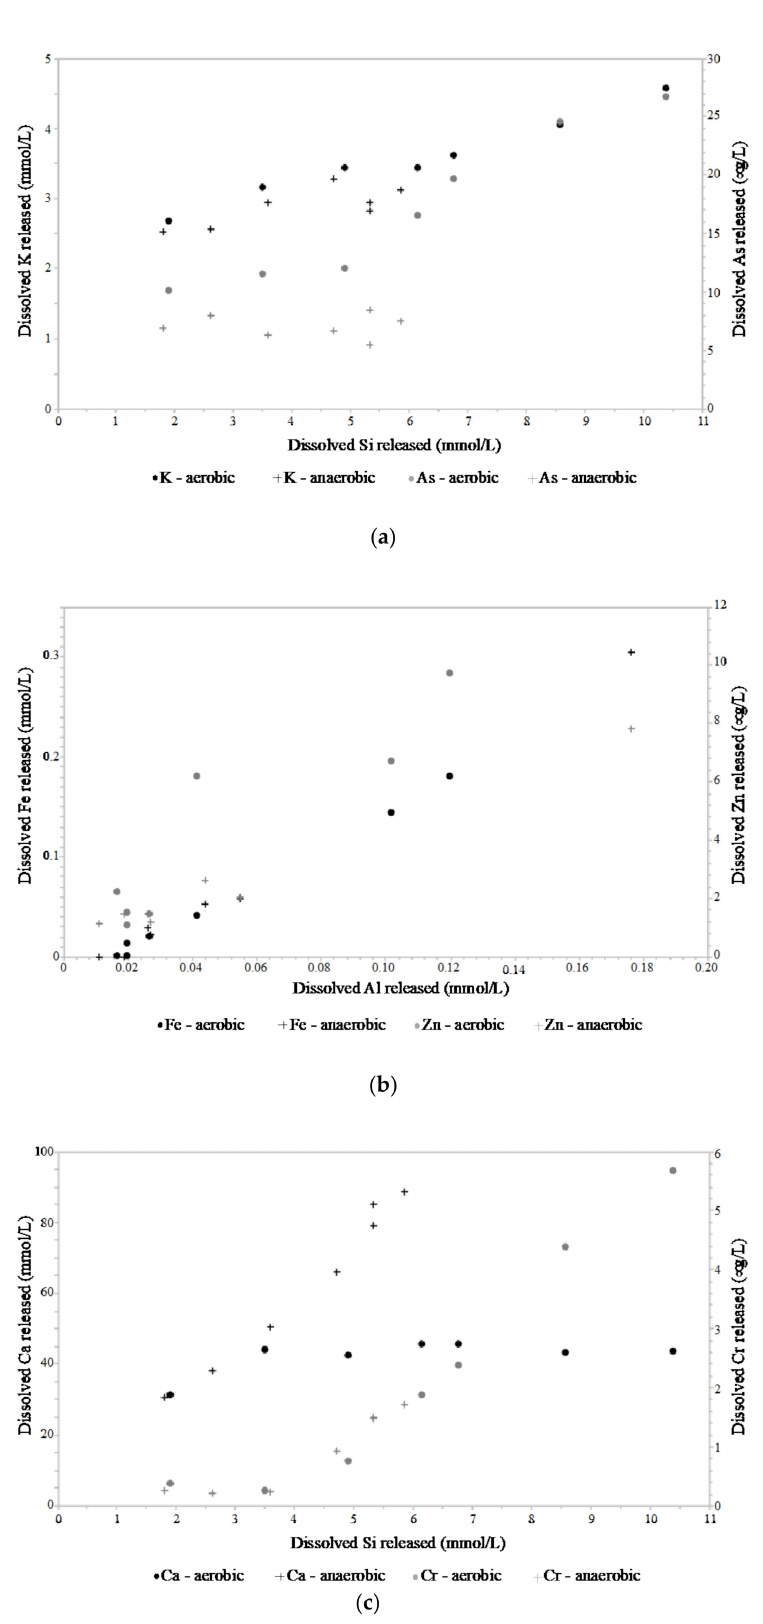
Figure 4. Temporal evolution of major (black symbol) and trace (grey symbol) elements released in the leachate during aerobic (circles) and anaerobic (crosses) leaching experiments for ( a ) Si, K and As; ( b ) Si, Ca and Cr; ( c ) Al, Fe and